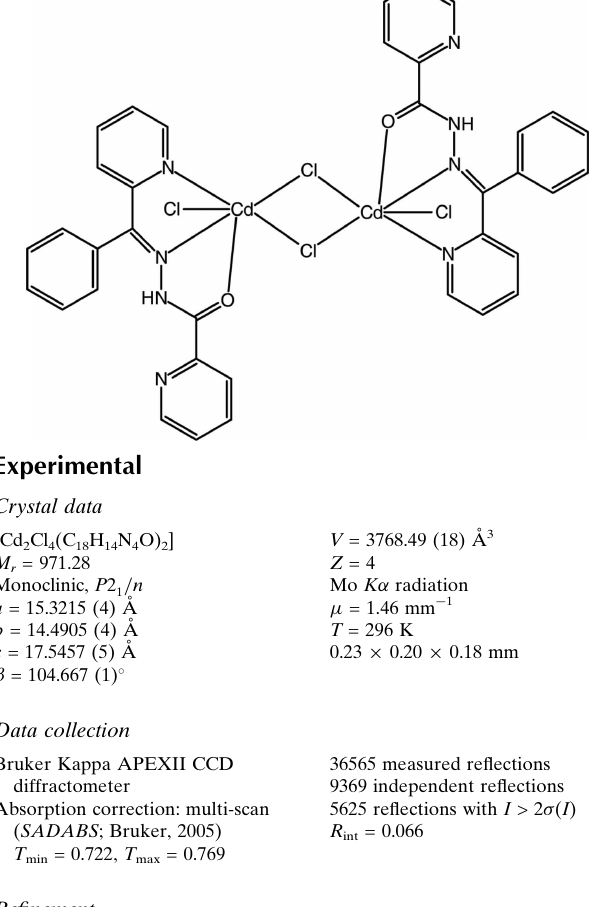
Data collection Bruker Kappa APEXII CCD diffractometer Absorption correction: multi-scan ( SADABS ; Bruker, 2005)